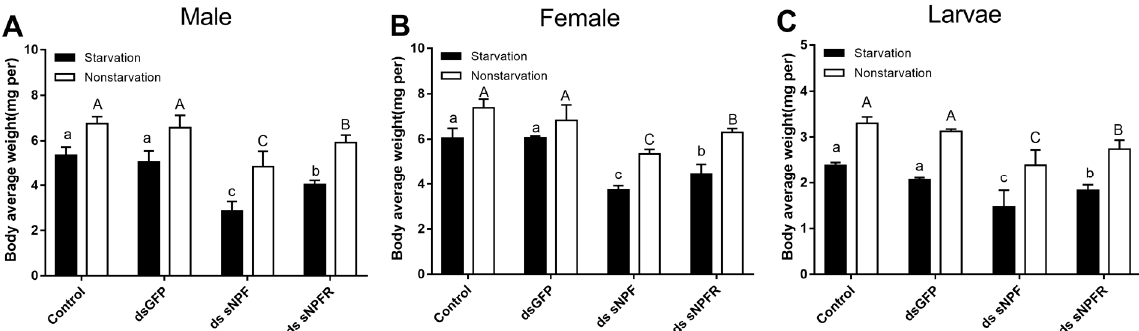
Figure 8. Effect of ds sNPF and ds sNPFR on body average weight. Samples were collected and assayed at 72 h after injection. In the RNAi experiments, body average weight of male ( A ), female ( B ), and larvae ( C ) in the states of starvation and non-starvation was analyzed. Different letters indicate significant differences at the 0.05 level. Tukey tests: uppercase for non-starvation, lowercase for starvation. All values are mean ± SE, n = 3.